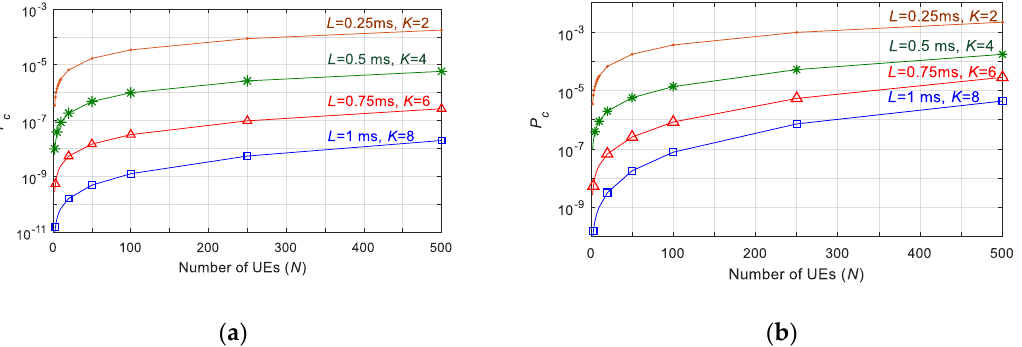
Figure 4. P c as function of the number of User Equipments (UEs) and for di ff erent latency requirements L : ( a ) λ = 0.1 packets; ( b ) λ = 1